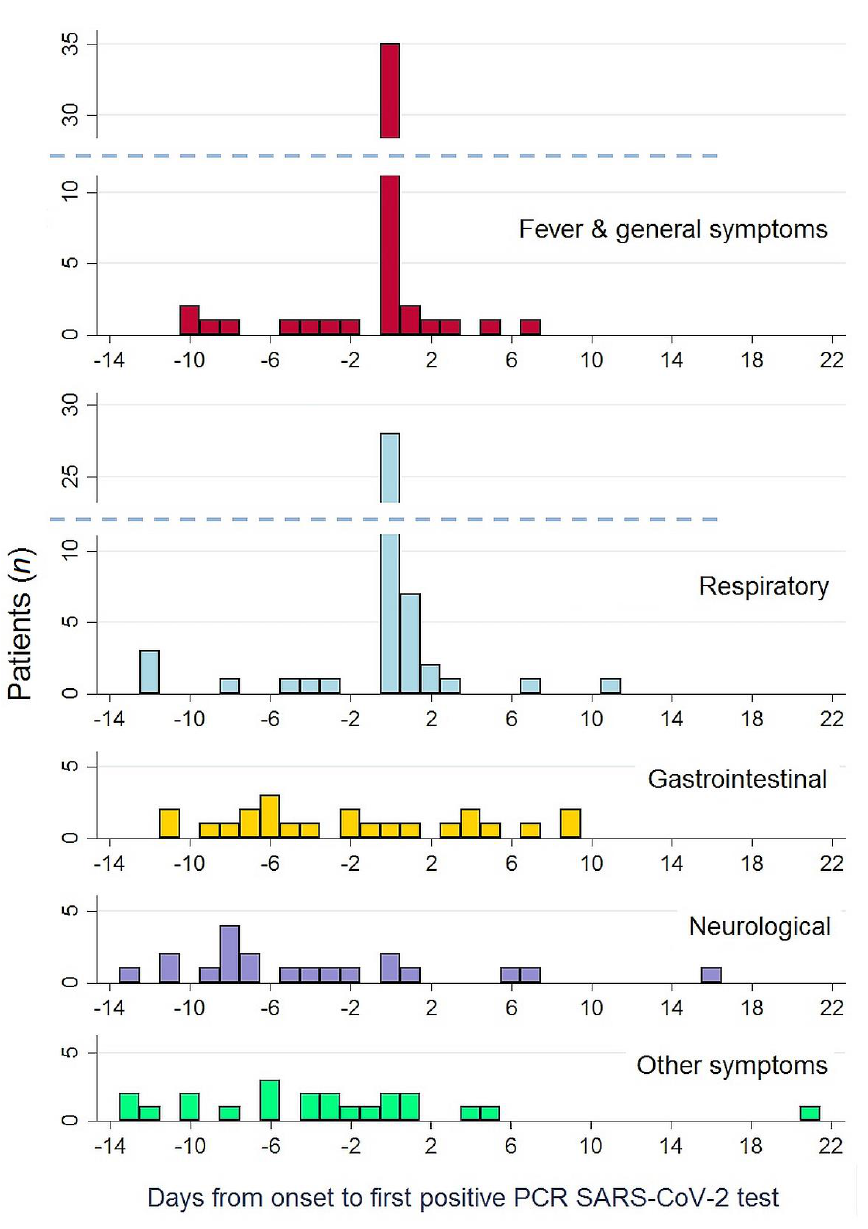
Figure 2. Temporal distribution of the onset of symptoms, by type.